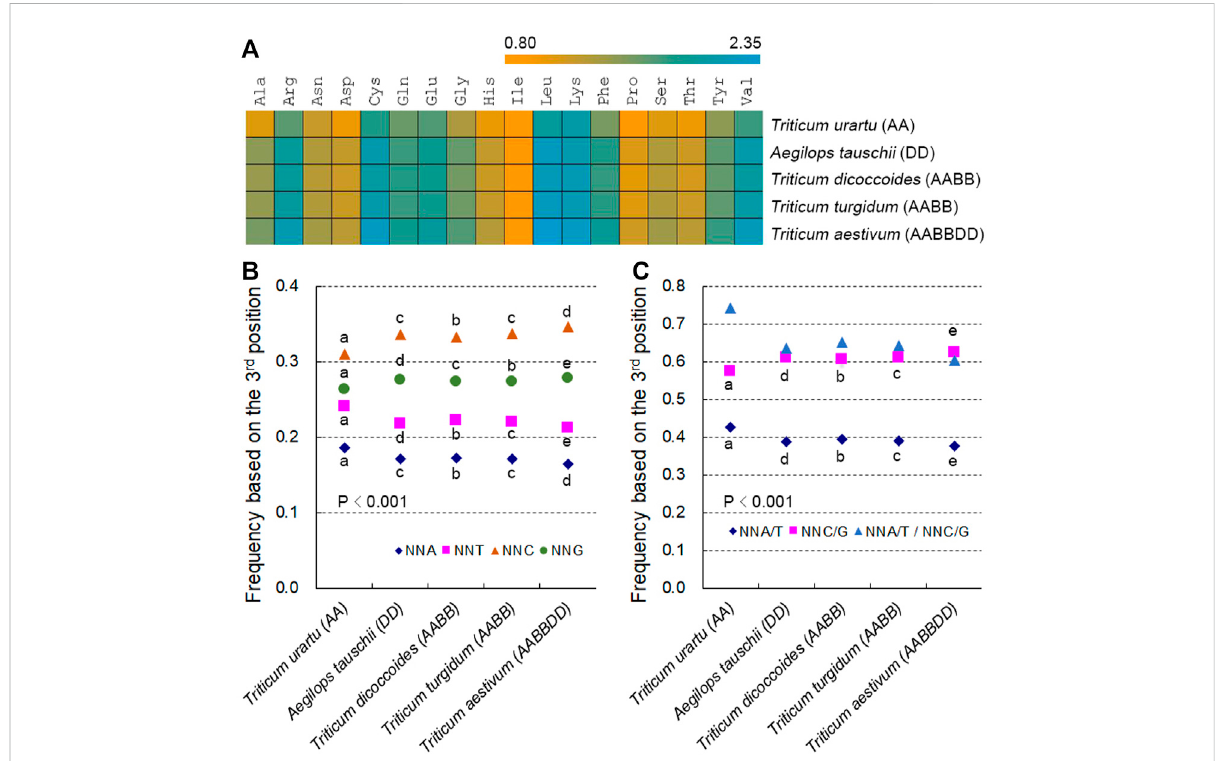
FIGURE 1 SCUB is heterogeneous between hexaploid wheat and its progenitors. (A) Ratio between the numbers of C/G-ending SCs and of A/T-ending SCs for 18 amino acids (Met and Trp not included). (B) Frequency of NNA, NNT, NNC and NNG codons. NNA, NNT, NNC and NNG: SCs with A, T, C andGasthe fi nalbase,respectively;Ndenotesanybase.ThefrequencywascalculatedastheratiobetweenthenumberofallSCsendingwithA,T,C orGandthetotalnumberofSCs. (C) FrequencyofNNA/TandNNC/Gcodons.NNA/TandNNC/G:SCswithAandTorCandGasthe fi nalbase, respectively; N denotes any base. The frequency was calculated as the ratio between the number of all SCs ending with A and T or C and G and the total number of SCs. Statistical comparison was conducted by Chi square ( χ 2 ) test; the difference between two species was calculated with Chi square partitioning; different lowercase letters represent signi fi cantly different values ( p <